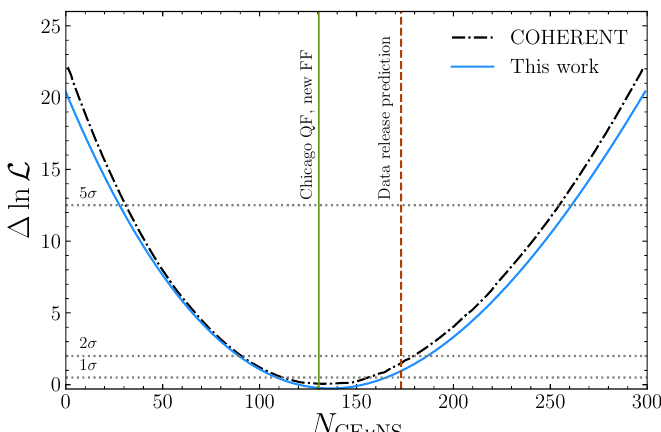
Figure 5 . Comparison of our (cid:31) 2 for the COHERENT timing and energy data as a function of the number of signal CE (cid:23) NS events under the same assumptions on the background, systematics and expected time and energy dependence of signal, compared to that provided by COHERENT in (cid:12)gure S13 of ref. [35]. For comparison, the vertical lines indicate the predicted event rates in the SM (with no systematic uncertainties), for di(cid:11)erent choices of QF and FF used: dashed red corresponds to the prediction provided in the data release of 173 events [36], while solid green indicates our prediction using the QF from ref. [58] (left panel in (cid:12)gure 1) and nuclear FF of [48, 49].